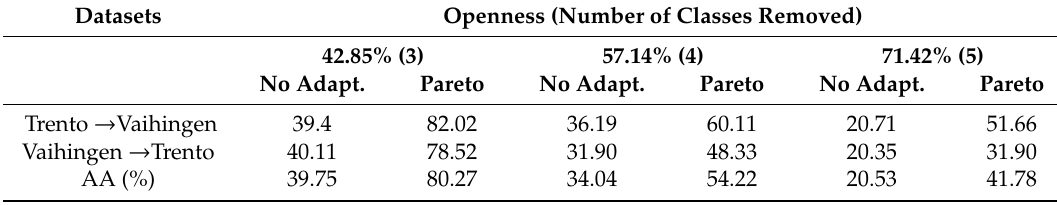
Table 9. Sensitivity analysis with respect to the openness for the EHR dataset. Results are expressed in terms of OS (%) and AA